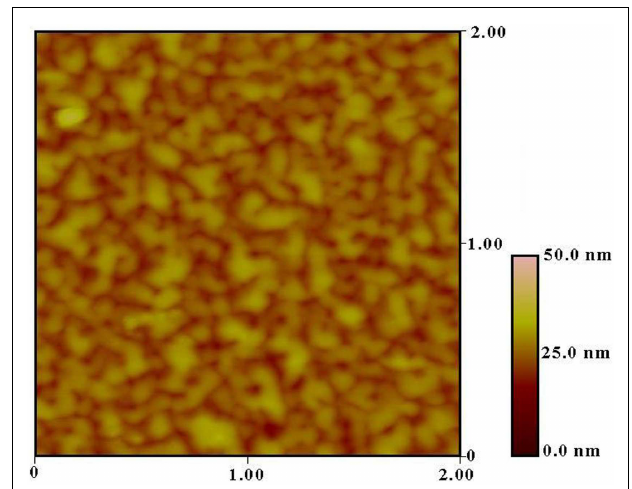
FIGURE 3 | MFM image of the SnFe 2 O 4 film .